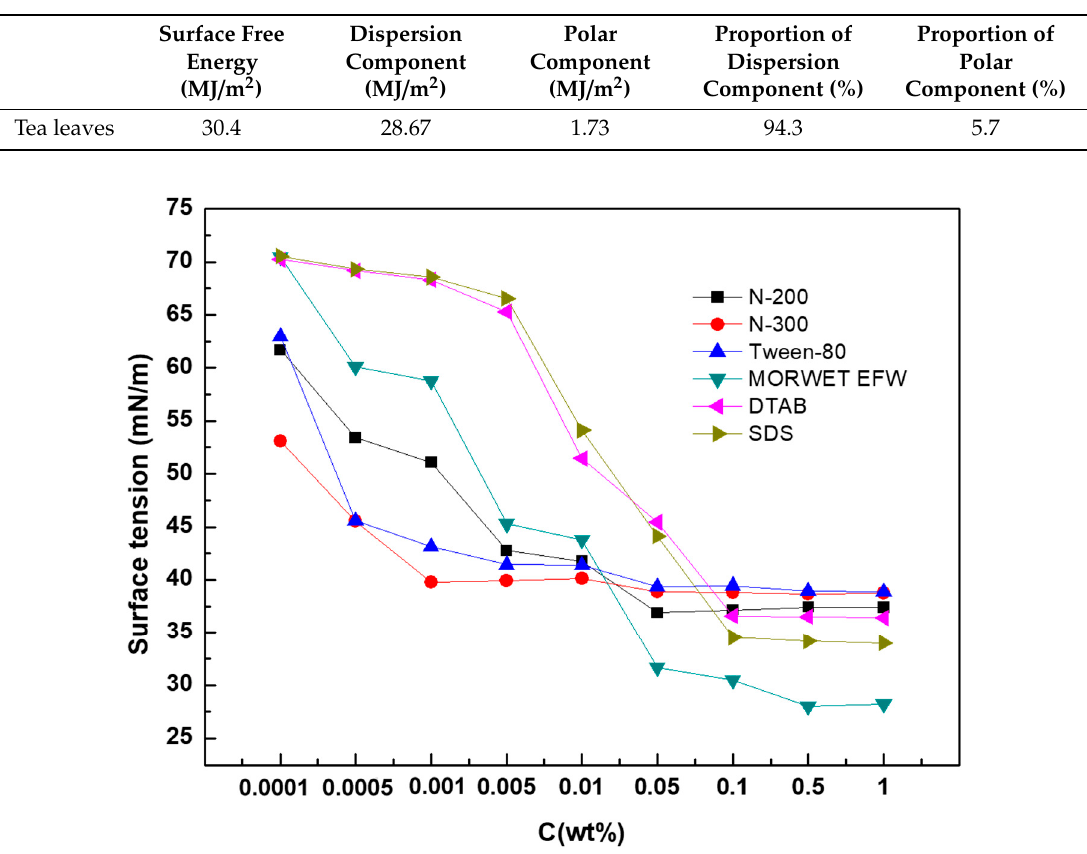
Figure 2. Surface tensions of aqueous surfactant solutions.